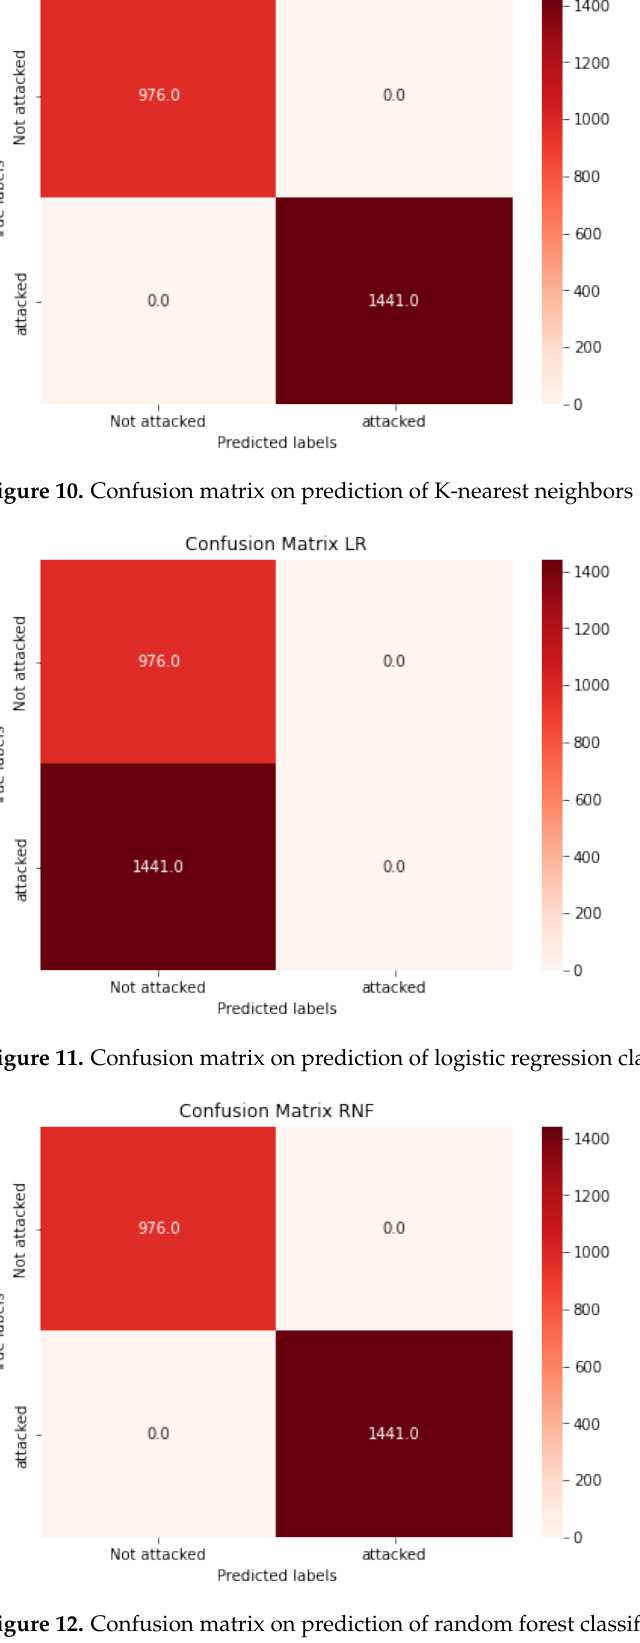
Figure 12. Confusion matrix on prediction of random forest